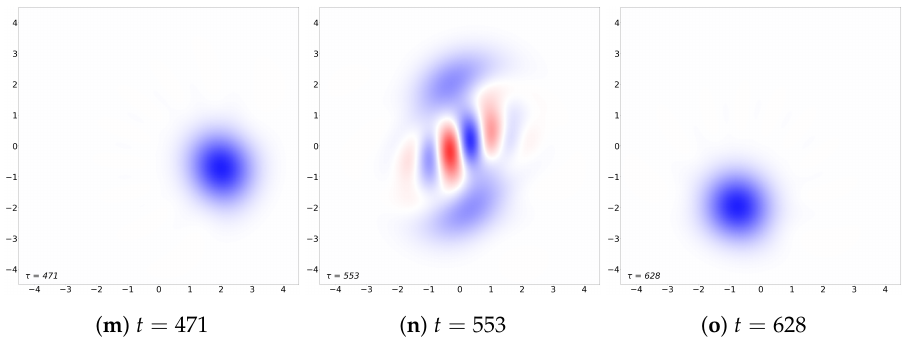
Figure 2. Snapshots in term of contour plot of the Wigner function of the evolving coherent state prepared inside optomechanical quantum memory for N = 10. The optical cavity decay rate γ c and the mechanical damping rate γ m = 0.00001 a.u. where the bath temperature corresponding to each mode is T = 0. Nonlinearities present in both the modes take the value k c = k m = 0.01 a.u. The Wigner plot for the initial coherent state at t = 0 a.u., an elliptical blue region,